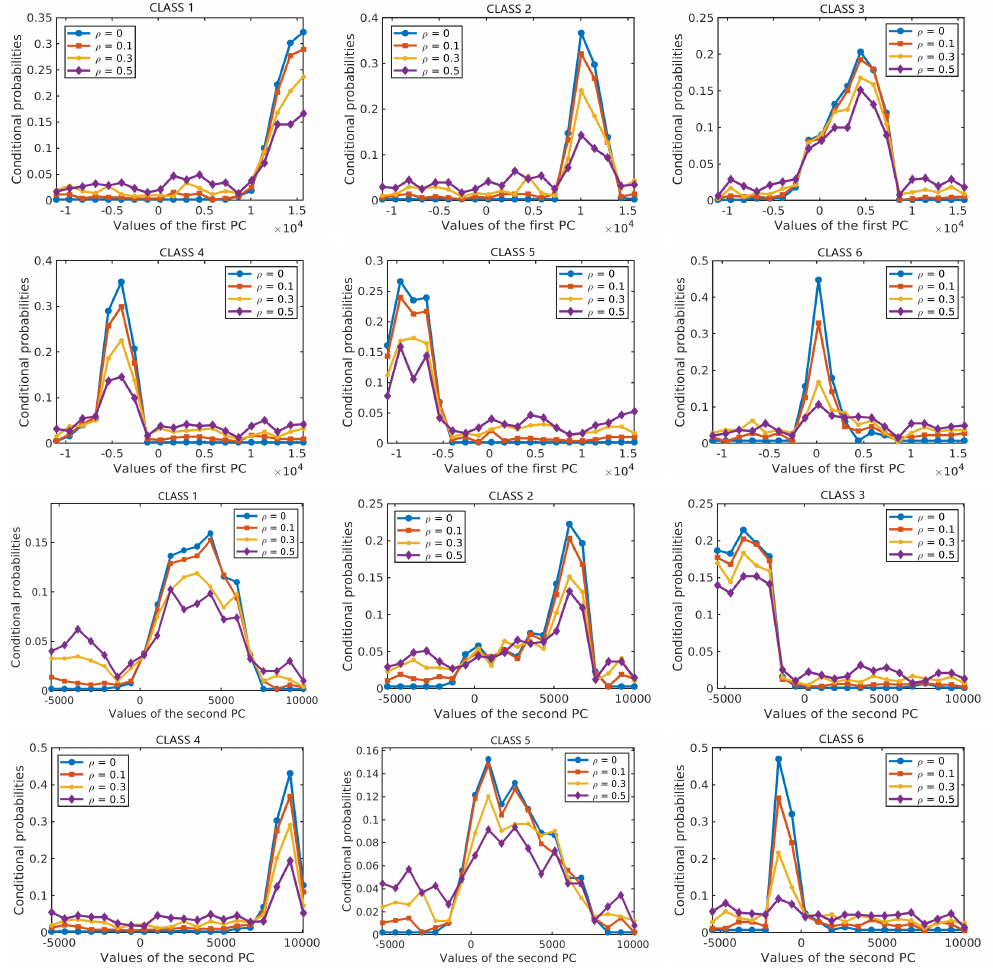
Figure 8. Conditional probabilities of the first PC ( top six diagrams ) and the second PC ( bottom six diagrams ) for different levels of label noise in the Salinas Scene data